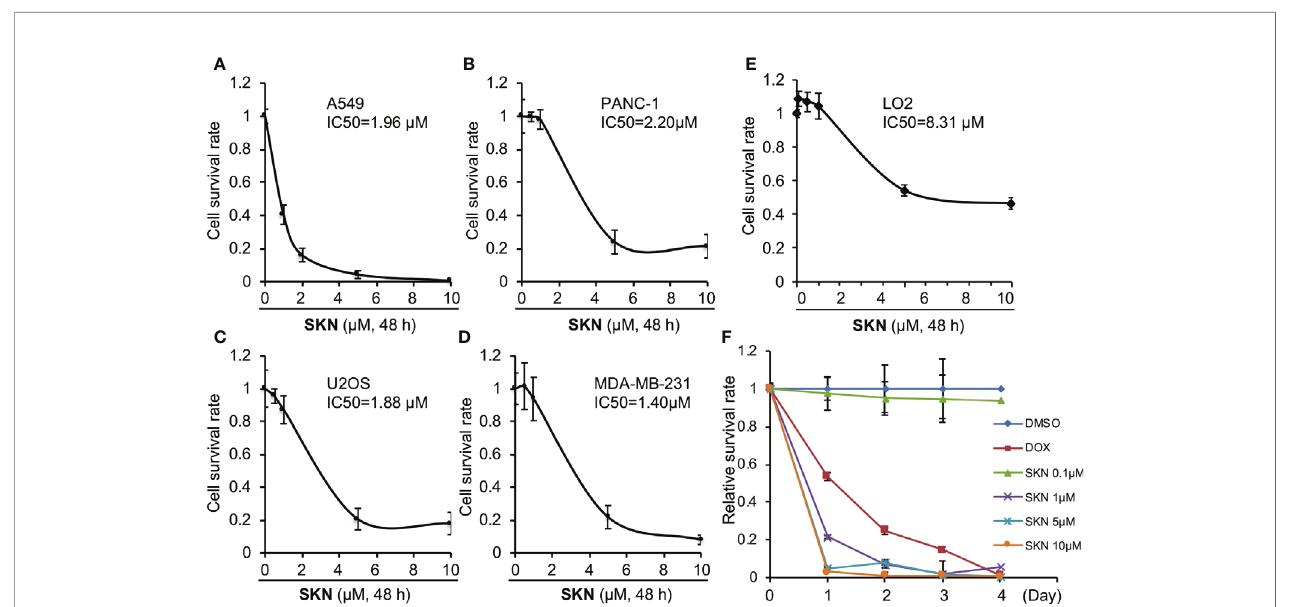
FIGURE 2 | Effects of Shikonin on cancer cell growth. A549 (A) , PANC-1 (B) , U2OS (C) , MDA-MB-231 (D) , or LO2 (E) cells were treated with indicated concentrations of Shikonin for 48 h, and cell survival was analyzed by the CCK-8 assay. Data were normalized to that of DMSO control and presented as relative survival rate from fi ve replicates. IC 50 values were analyzed using the GraphPad software. (E) A549 cells were treated with DMSO or different concentrations of Shikonin or 10 m M doxorubicin (DOX) for 1, 2, 3 and 4 days, and cell survival was analyzed by the CCK-8 assay. The absorbance of Shikonin-treated group was normalized to that of the same day DMSO control, which yields the relative survival rate. Data represent mean and standard deviation from fi ve replicates. (F) A549 cells were treated with DMSO or different concentrations of Shikonin for 1, 2, 3 and 4 days, and cell survival was analyzed by CCK-8 assay. The absorbance of Shikonin-treated group was normalized to that from the same day DMSO control, which yields the relative survival rate. Data represent mean and standard deviation from fi ve